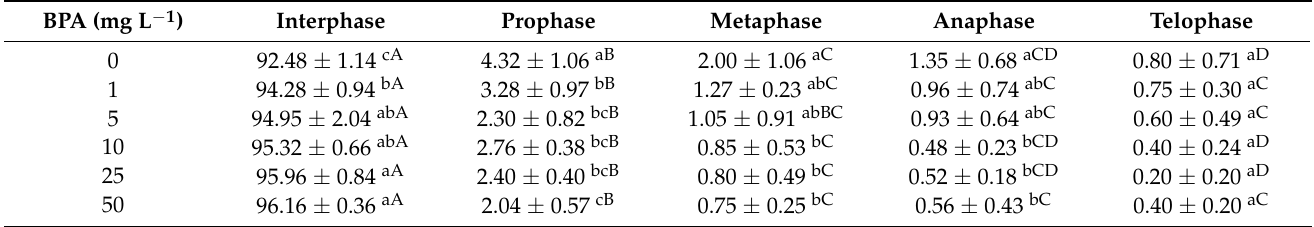
Table 1. Distribution of root meristem cells of Allium cepa through phases of cell cycle after 3